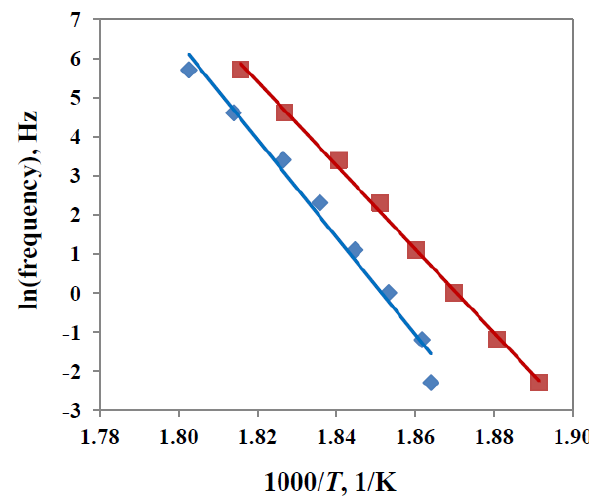
Figure 13. Plot of ln(frequency) versus inverse temperature for the frequency shift of the loss modulus curves, for two TGAP/MMT/DDS nanocomposite systems: red squares, 5 wt% clay content; blue rhombus, 2 wt% clay content.